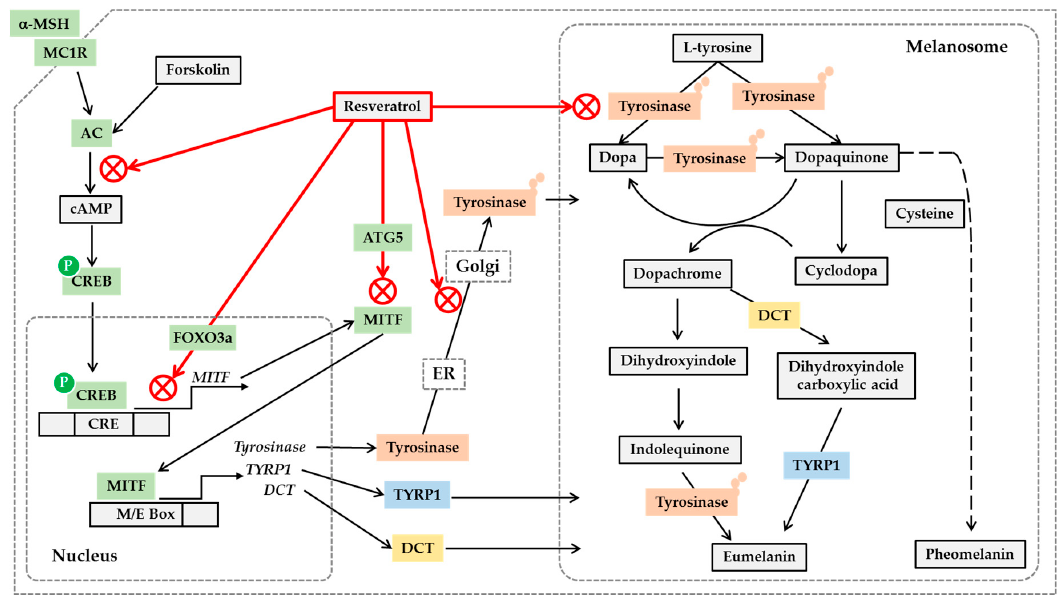
Figure 2. Potential mechanisms for the antimelanogenic action of resveratrol. On the binding of α -melanocyte stimulating hormone ( α -MSH) to the melanocortin 1 receptor (MC1R) and subsequent activation of cyclic AMP (cAMP)-producing adenylate cyclase (AC), leads to the phosphorylation of cAMP-responsive element-binding protein (CREB) by protein kinase A. Phosphorylated CREB enters nucleus and binds to cAMP response elements (CRE) on the promoter of its target genes including microphthalmia-associated transcription factor (MITF), activating their gene expression. Resveratrol can inhibit the gene expression of MITF, tyrosinase, tyrosinase-related protein 1 (TYRP1) and dopachrome tautomerase (DCT) stimulated by α -MSH or forskolin, a director activator of AC, which is mediated by a cAMP-dependent mechanism. Resveratrol can suppress MITF activation by a FOXO3a-dependent mechanism. Resveratrol can also stimulate autophagy-related gene 5 (ATG5) expression inducing autophagy, and reduce the protein levels of MITF and tyrosinase. The antimelanogenic enzymes such as tyrosinase undergo posttranslational modifications in the endoplasmic reticulum (ER) and Golgi, and resveratrol can inhibit these processes. Resveratrol can also inhibit enzyme reactions of tyrosinase involved in the synthesis of eumelanin and pheomelanin in the melanosomes. Although the synthetic route of pheomelanin is simply drawn here, it is very complicated and involves many enzymes and metabolites. There are many other pathways that are involved in the regulation of cellular melanin synthesis, but are not covered in this figure.